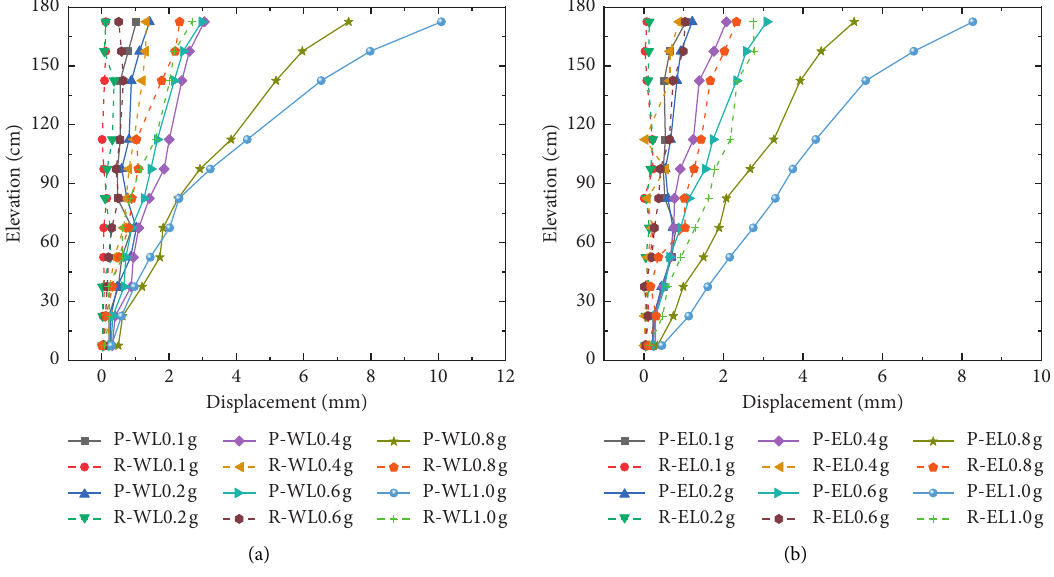
Figure 10: Lateral displacement distributions of the specimen (scale factor: 1/4): (a) WL and (b) EL.